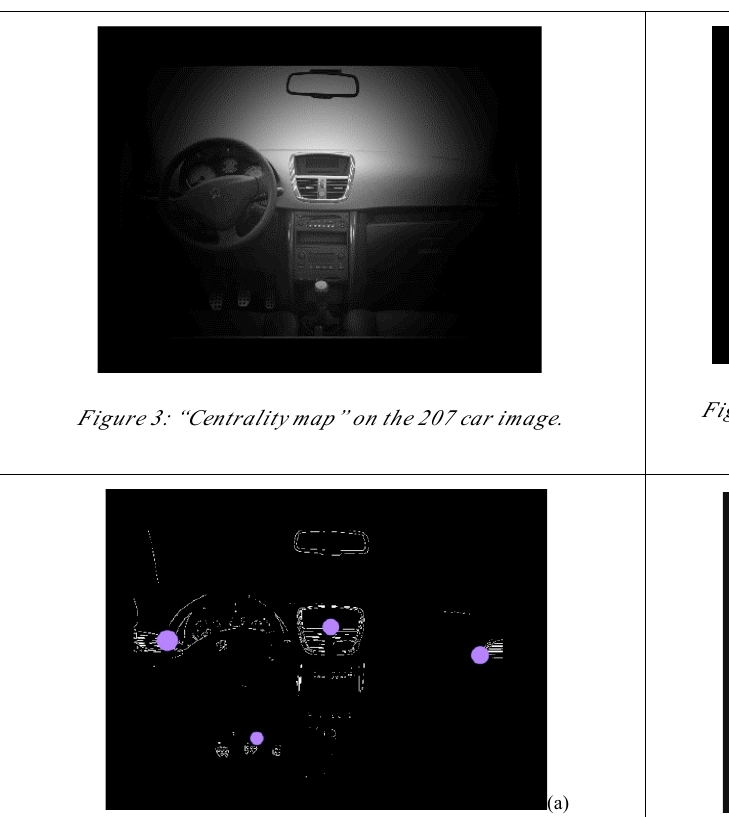
Figure 5: Set up the « Maximization » map for the 207 image from (a ) a Edge filter and clustering -here 4 clusters-